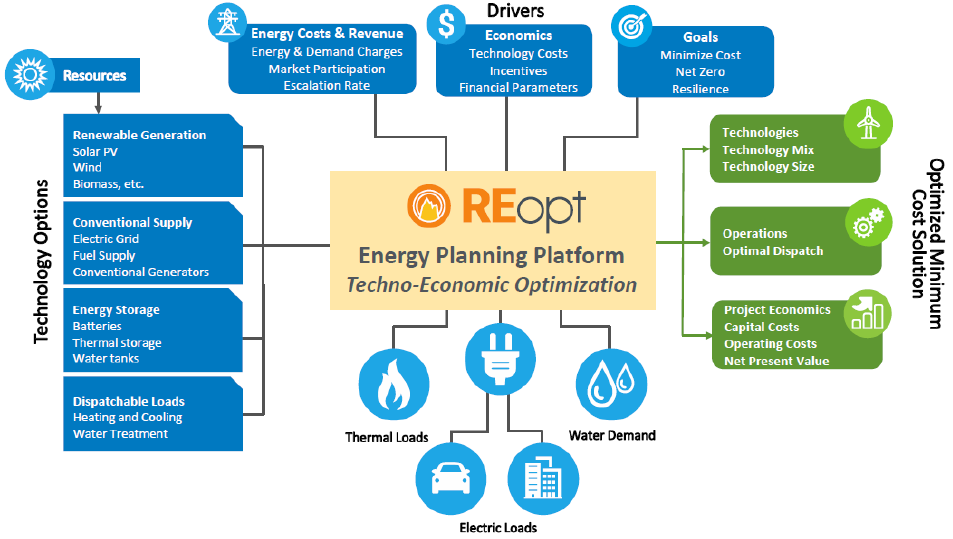
Figure 1. REopt software’s basic inputs and outputs [22]. Used with permission.